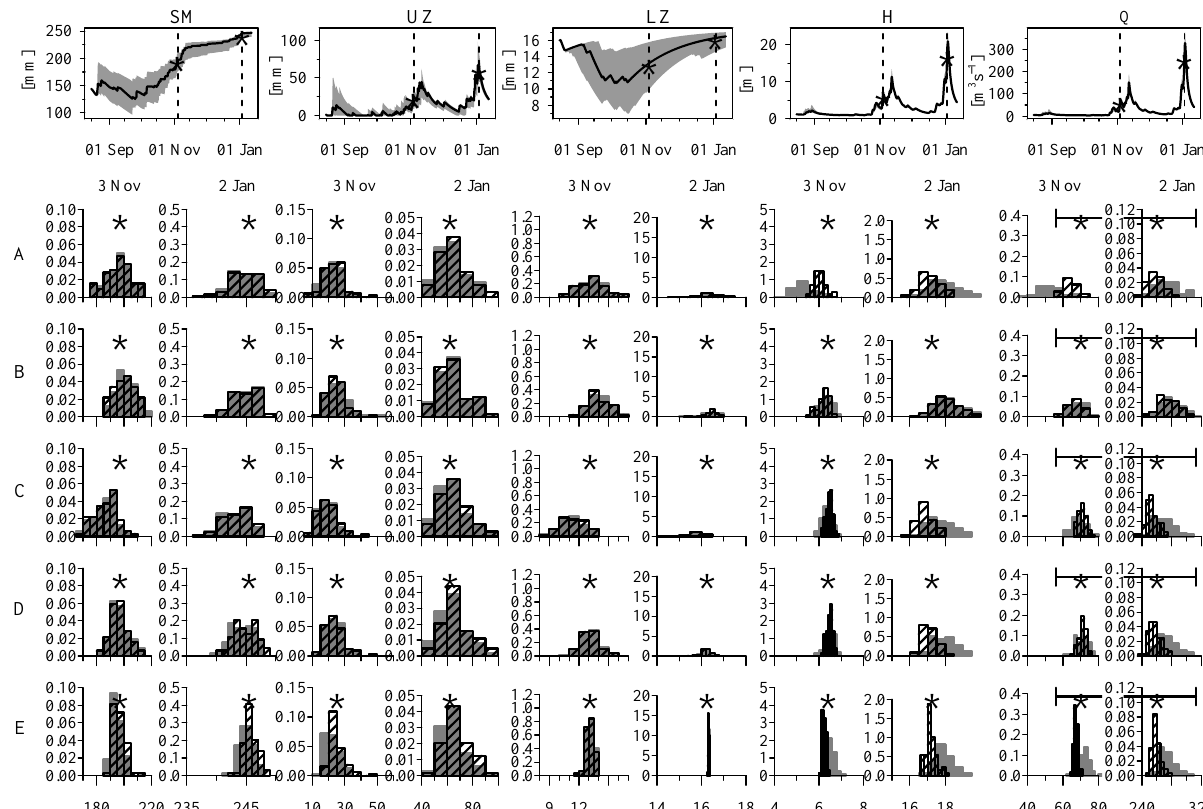
Fig. 6. Synthetic experiment. Top: Open loop model state simulations (grey lines) including the true states (black line) at location 1 in Fig. 1b. Bottom: Forecasted (grey histograms) and analysed (dashed histograms) model states at location 1 for two dates (3 November and 2 January) and considering 5 discharge observation vectors (A, B, C, D, E). The true states are indicated by asterisks and the error bars represent the 95% confidence bounds of the observation errors ( ν k in Eq.